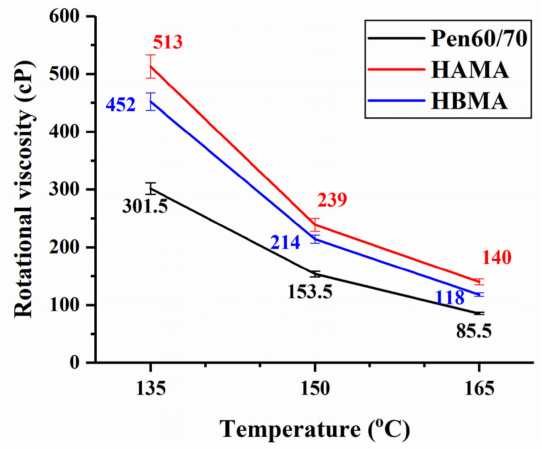
Figure 5. Rotational viscosity test